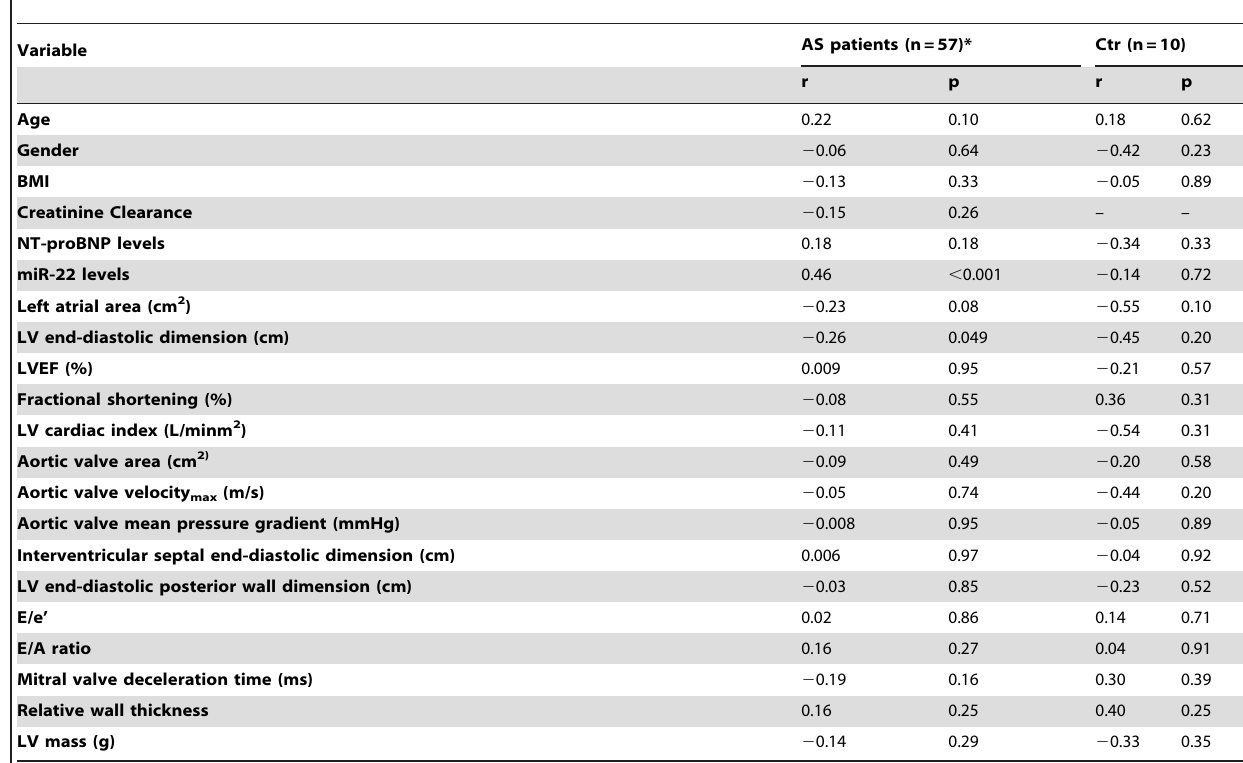
Table 3. Correlations in AS patients and control subjects (Ctr) between miR-210 levels and clinical and echocardiographical parameters of myocardial structure and function.